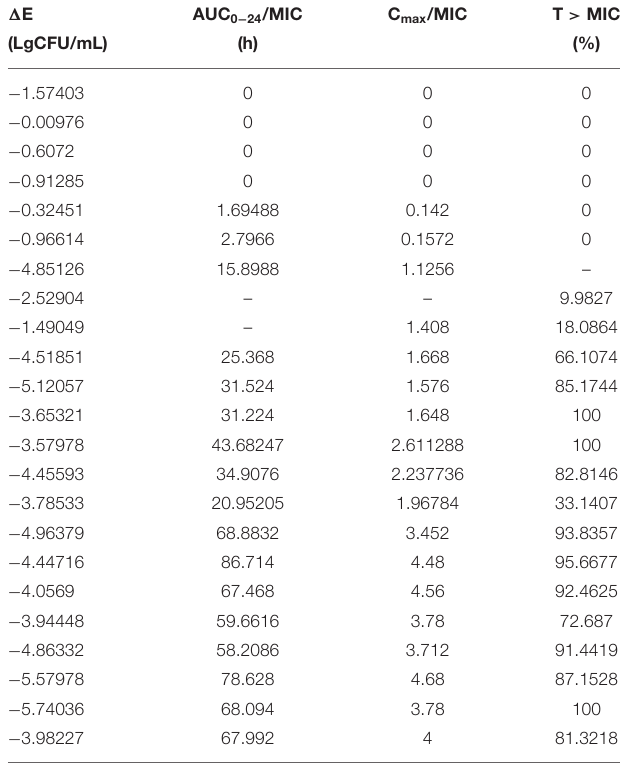
TABLE 1 | Tissue cage fluid pharmacokinetic parameters of tulathromycin following a single-dose intramuscular injection. Dosage (mg/kg)